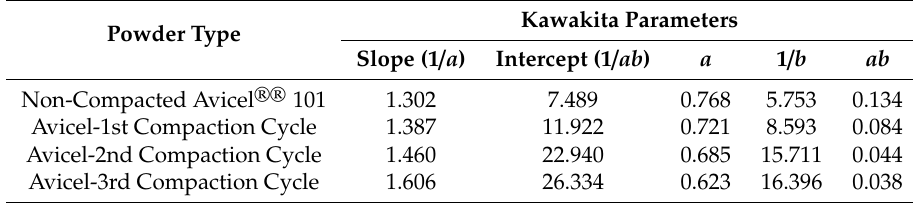
Figure 11. Kawakita plot of non-compacted and compacted Avicel PH-101. Table 4. Parameters derived from the Kawakita plots of non-compacted and compacted Avicel ®® PH-101.